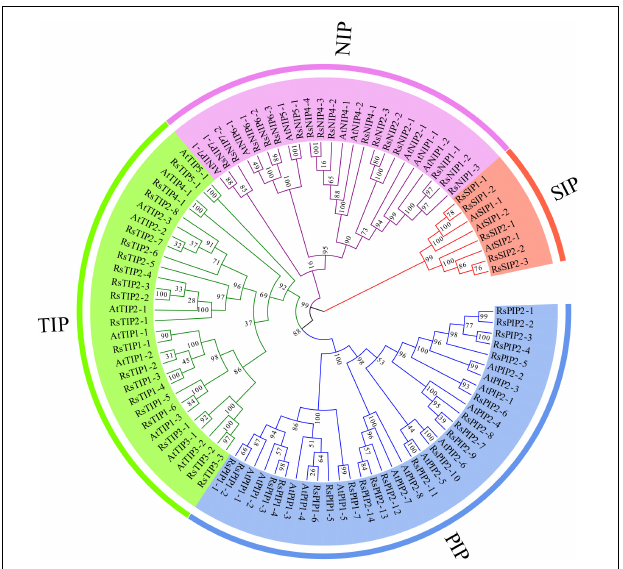
FIGURE 1 | Phylogenetic relationship between the members of RsAQP and